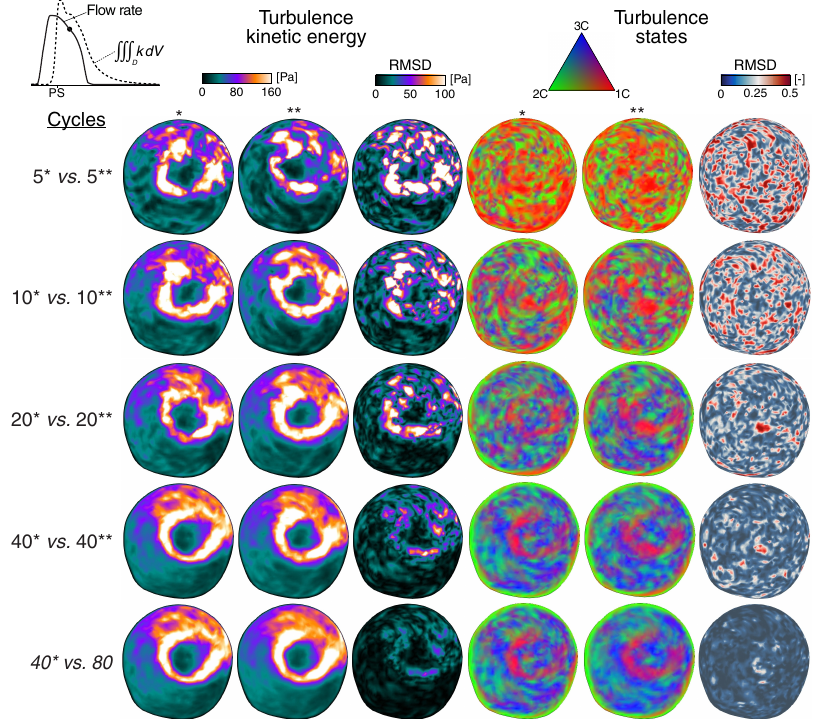
Figure 5. Phase-averaging effects on the phase-instant Reynolds stress characteristics at one stenotic diameter (1D) downstream of the constriction. Phase-averaged results were compared for different non-overlapping cycle ranges (* vs. **) sampled over the full range ( N = 80) of computed cardiac cycles. The mean RMSD errors over all cross-sections are given in Figure 3 (Instant, blue and brown bars). For additional details see Figure 2.